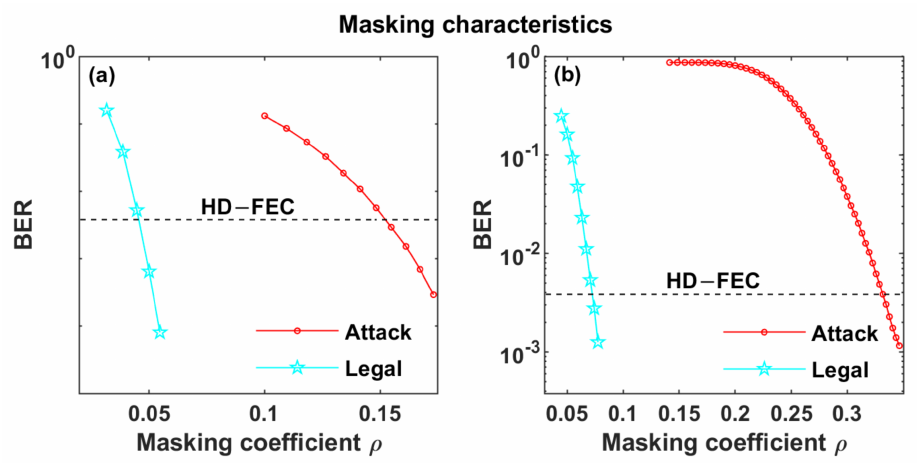
Figure 6. Masking characteristics of ( a ) Message 1 and ( b ) Message 2.